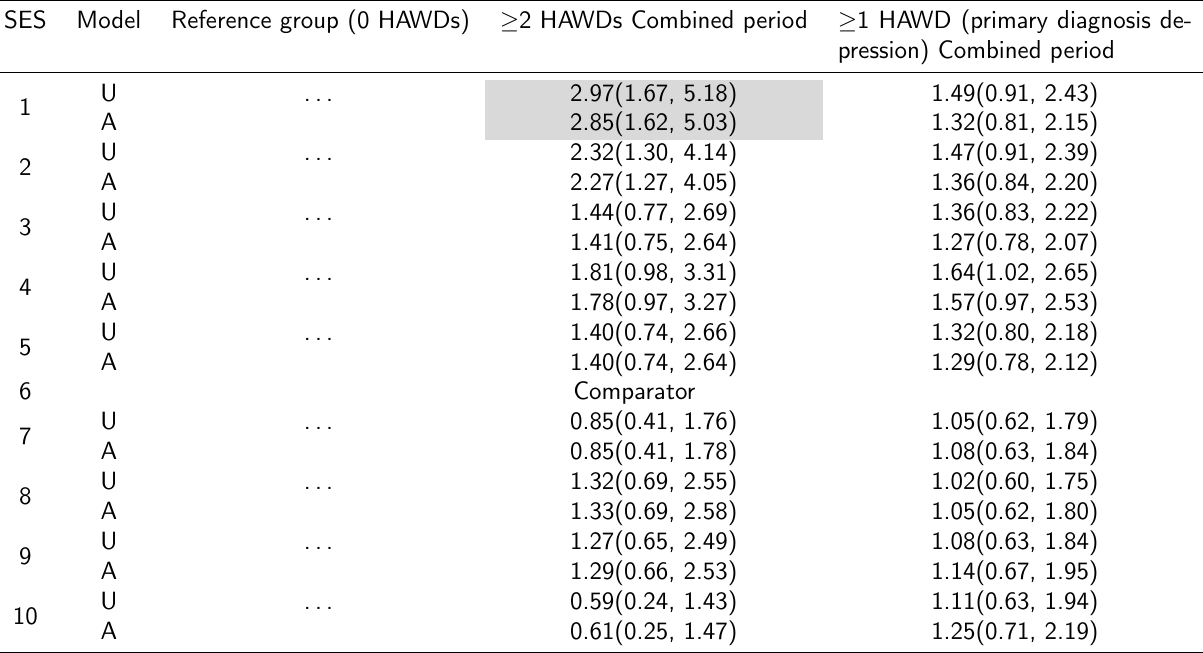
Table 4: Odds ratios of at least two HAWDs and at least one HAWD associated with a primary diagnosis of depression